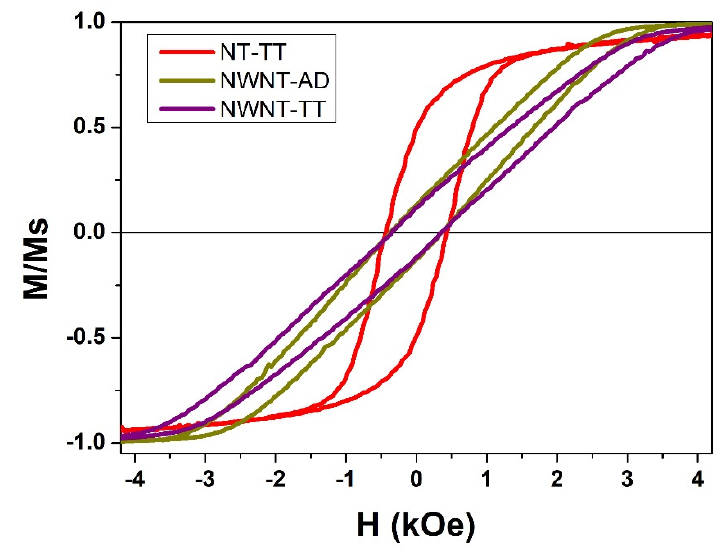
Figure 4. Comparison of the normalized hysteresis loops measured at 300 K for the NT-TT, NWNT- AD and NWNT-TT samples by applying the external field along the parallel direction with respect to the nanowire/nanotube longitudinal axis.